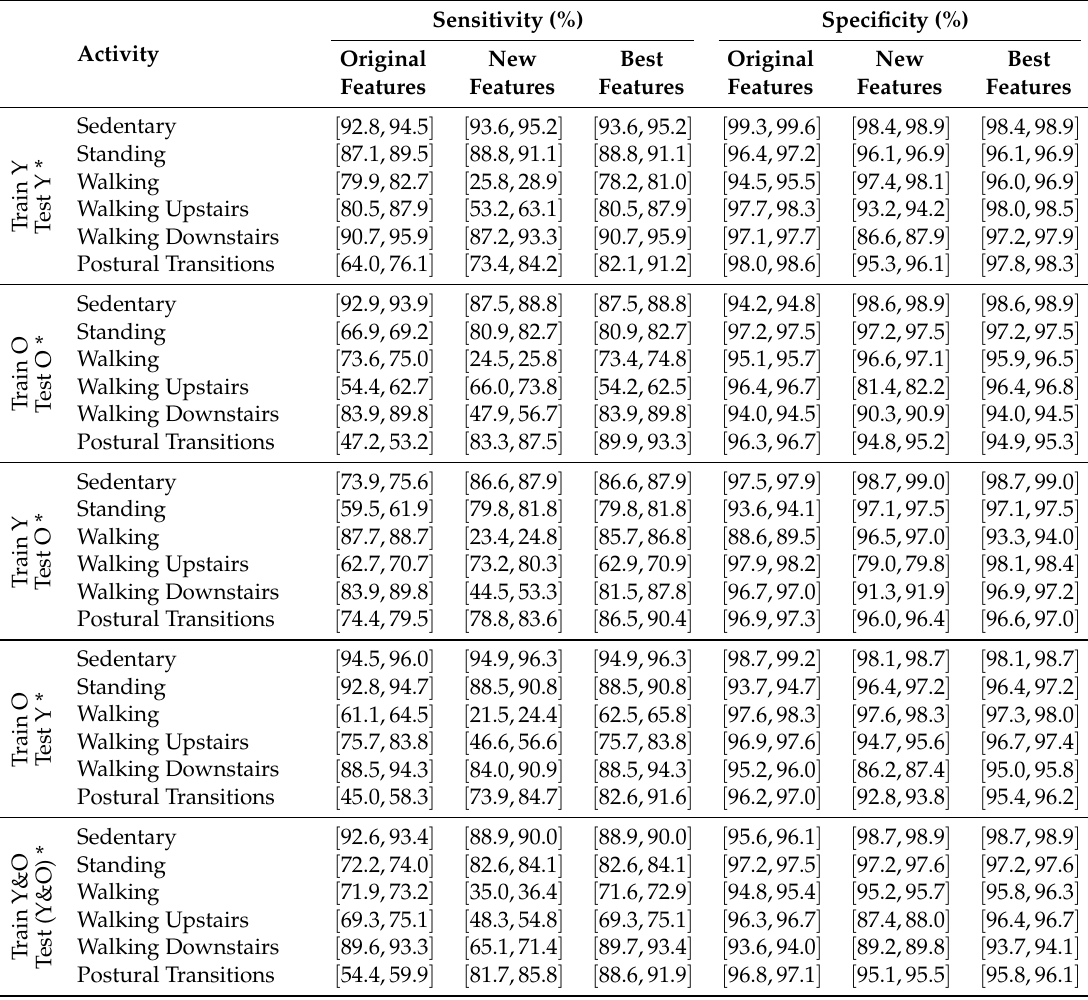
Table A1. Ninety-five percent confidence intervals for the sensitivity and specificity of each activity class when HMHA were developed with different feature subsets ( f IMU = 100 Hz; f bar = 16